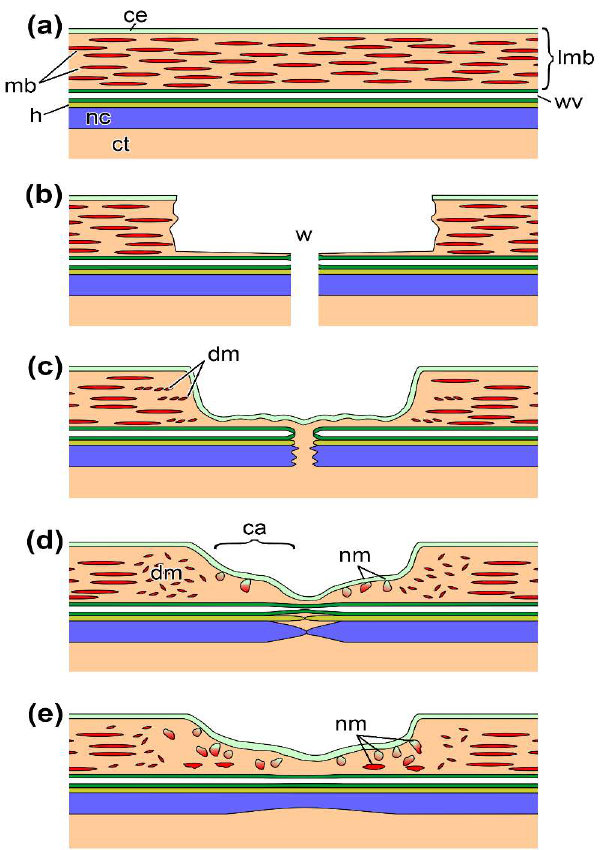
Figure 1. Scheme of a longitudinal section through ambulacrum at different stages after transverse cutting of a holothurian, E. fraudatrix . ( a ) Undamaged ambulacrum. ( b ) The ambulacrum immediately after cutting. ( c ) The ambulacrum at 2–4 dpd. ( d ) The ambulacrum at 10th dpd (first stage of regeneration). ( e ) The ambulacrum at 20th dpd (second stage of regeneration). ca, connective-tissue thickening (anlage); ce, coelomic epithelium; ct, connective tissue of the body wall; dm, destroyed muscle bundle; h, hemal lacuna; lmb, longitudinal muscle band; mb, muscle bundles; nc, radial nerve cord; nm, new muscle bundles; wv, radial water-vascular canal; w,